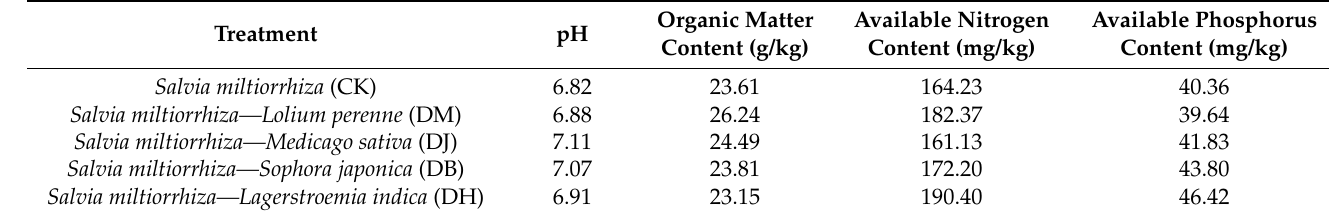
Table 1. Sampling point location and information.